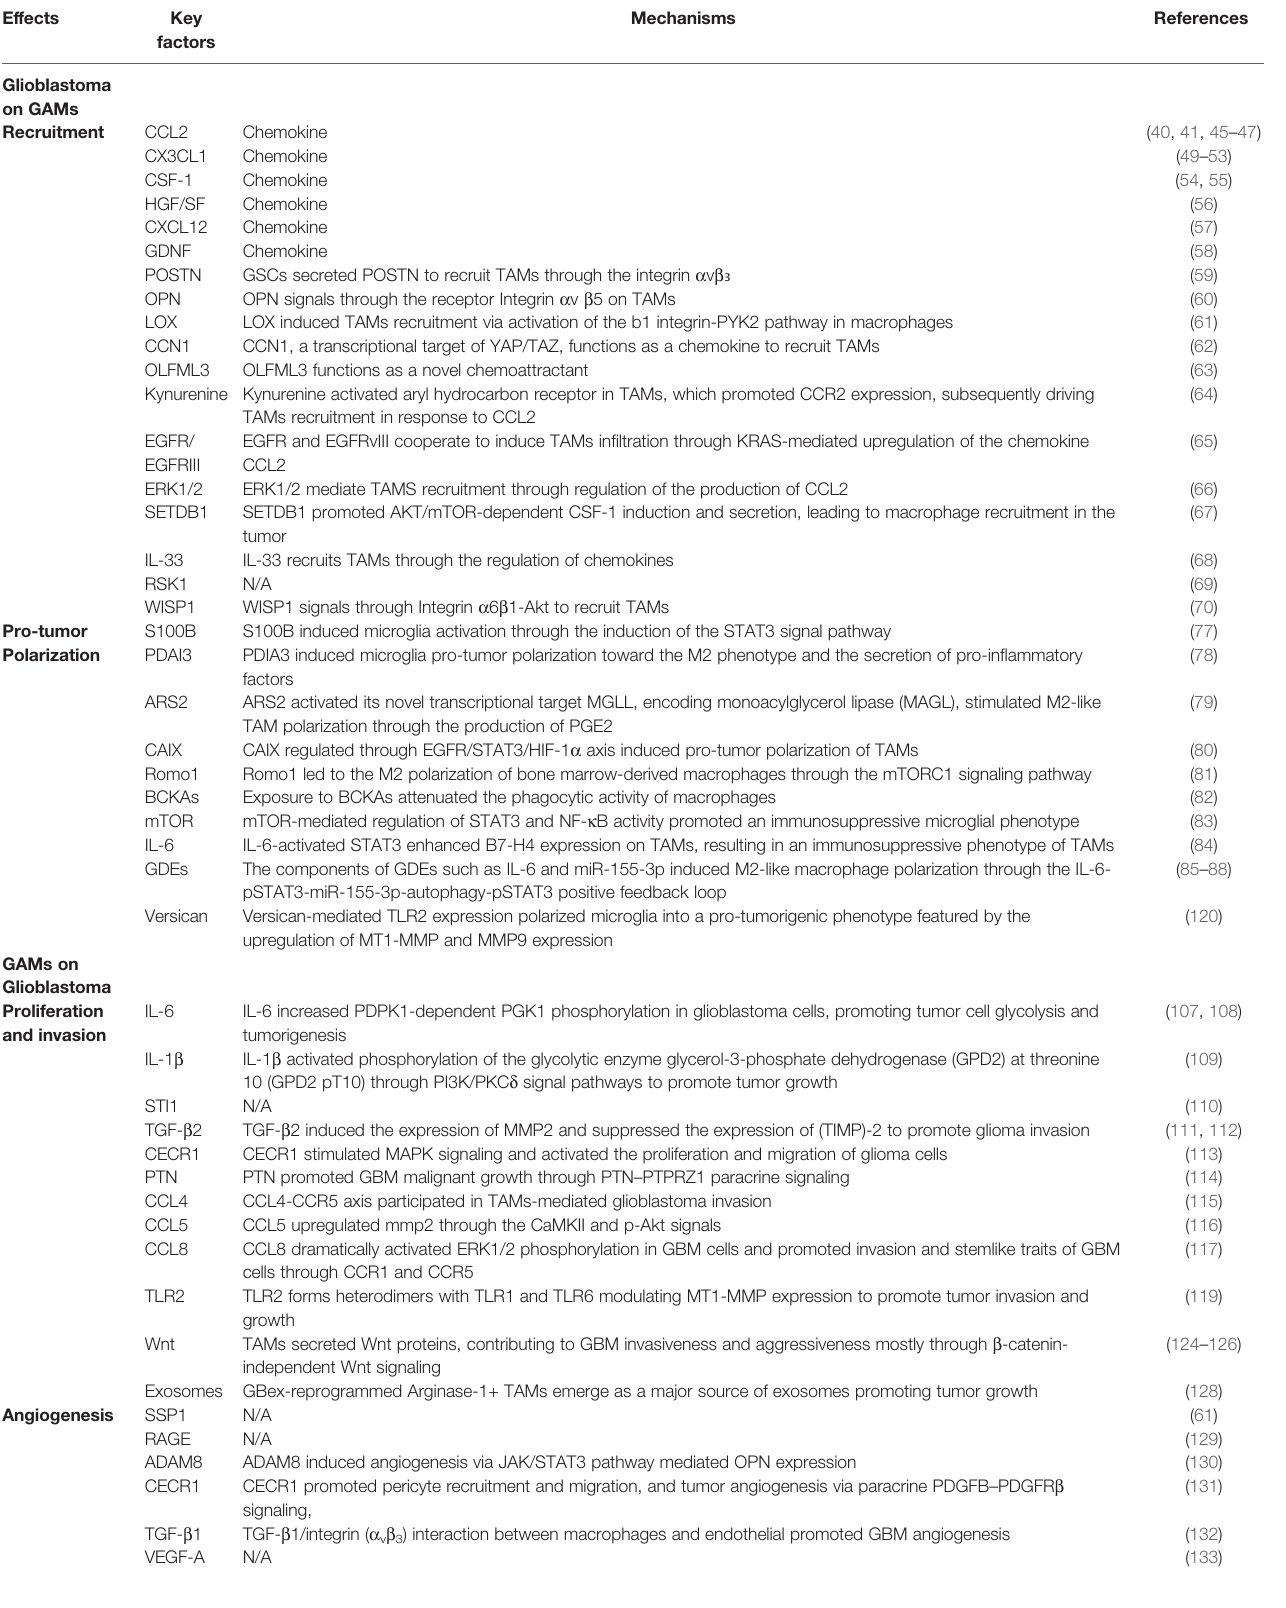
TABLE 1 | Interactions between Glioblastoma and